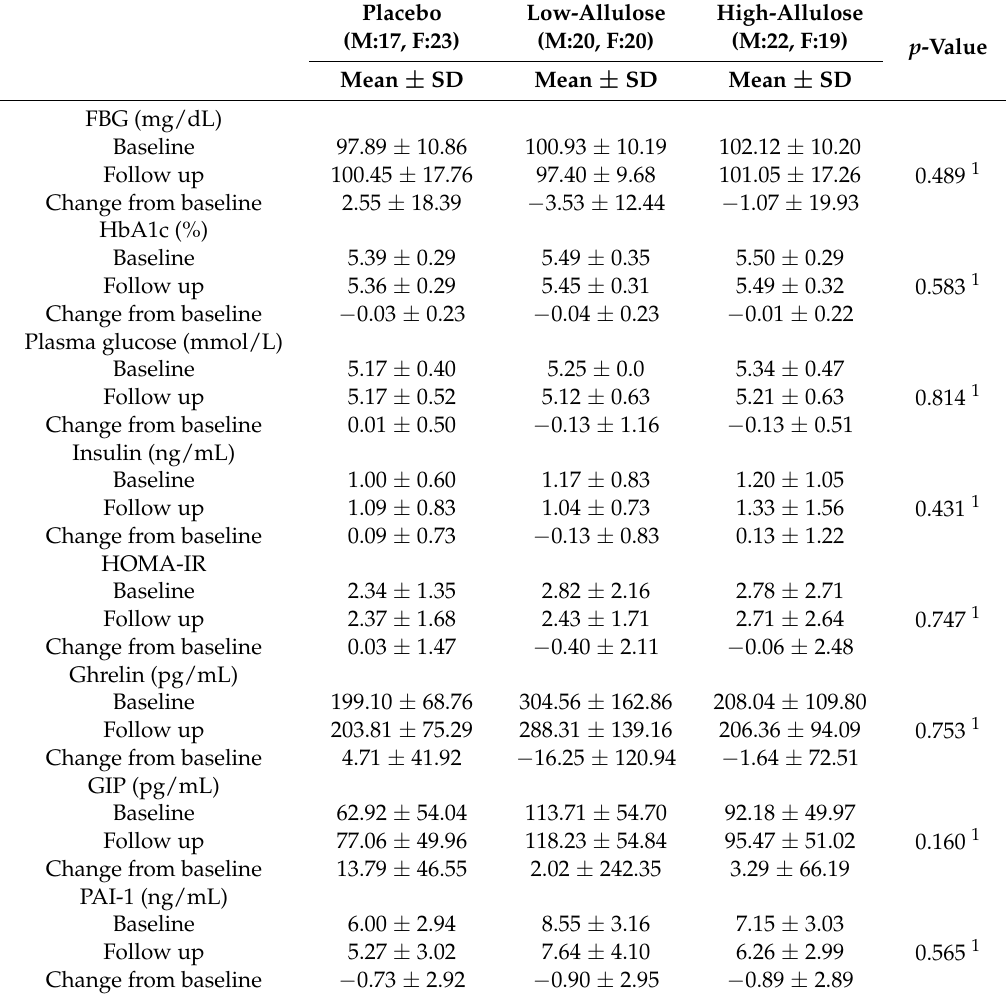
Table 7. Dose-dependent effect of D -allulose supplementation for 12 weeks on fasting blood glucose, HbA1c, plasma glucose, insulin, HOMA-IR, ghrelin, GIP, and PAI-1 in overweight or obese